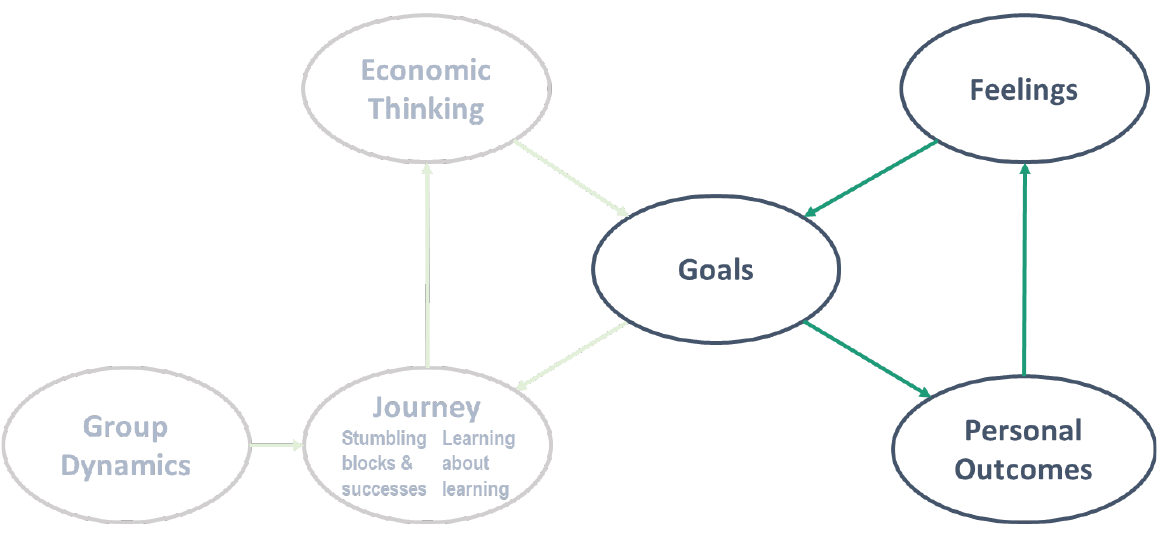
Figure 3 : Systems Influence Diagram: The ‘ H eart’ loop Because Goals mediated and fed back the influence of emotional responses and